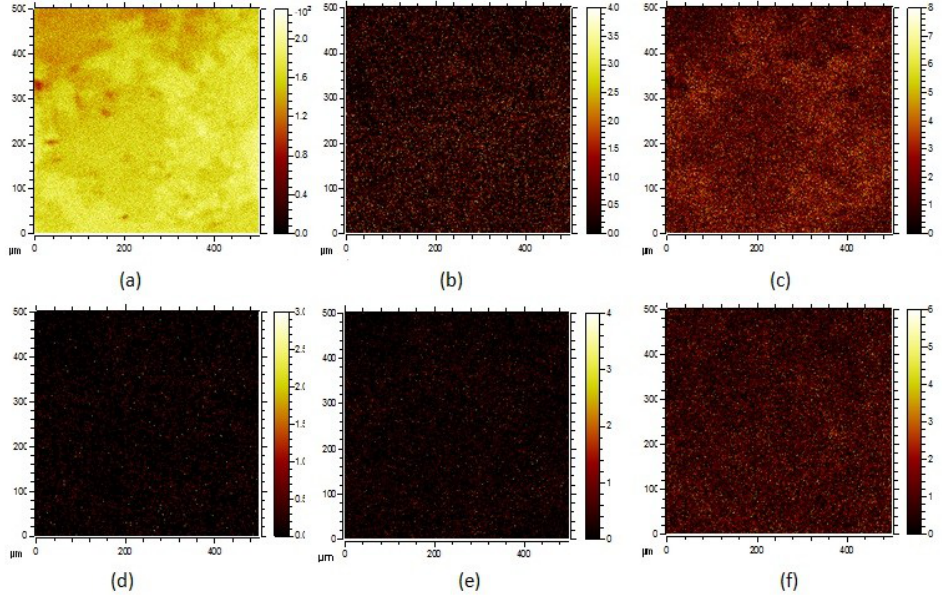
Figure 7. Two-dimensional distributions of ions on the dolomite surface (500 × 500 µm 2 ) treated with H 2 SO 4 (1 × 10 −3 mol/L) and oleate (2 × 10 −4 mol/L): ( a ) overlap, ( b ) SO 4− , ( c ) CO 3− , ( d ) CaO − , ( e ) MgO − , and ( f ) C 2 H 3 O 2− .